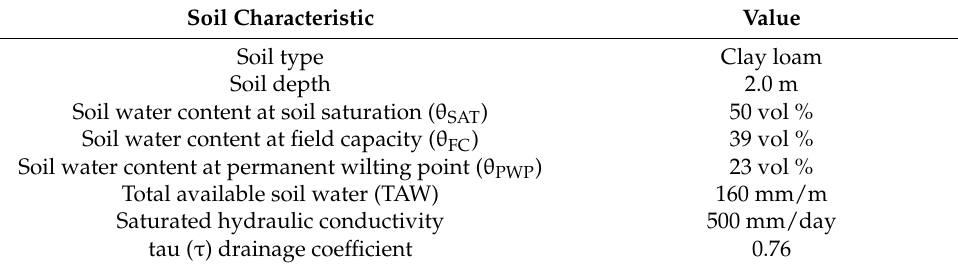
Table 3. Soil input data for